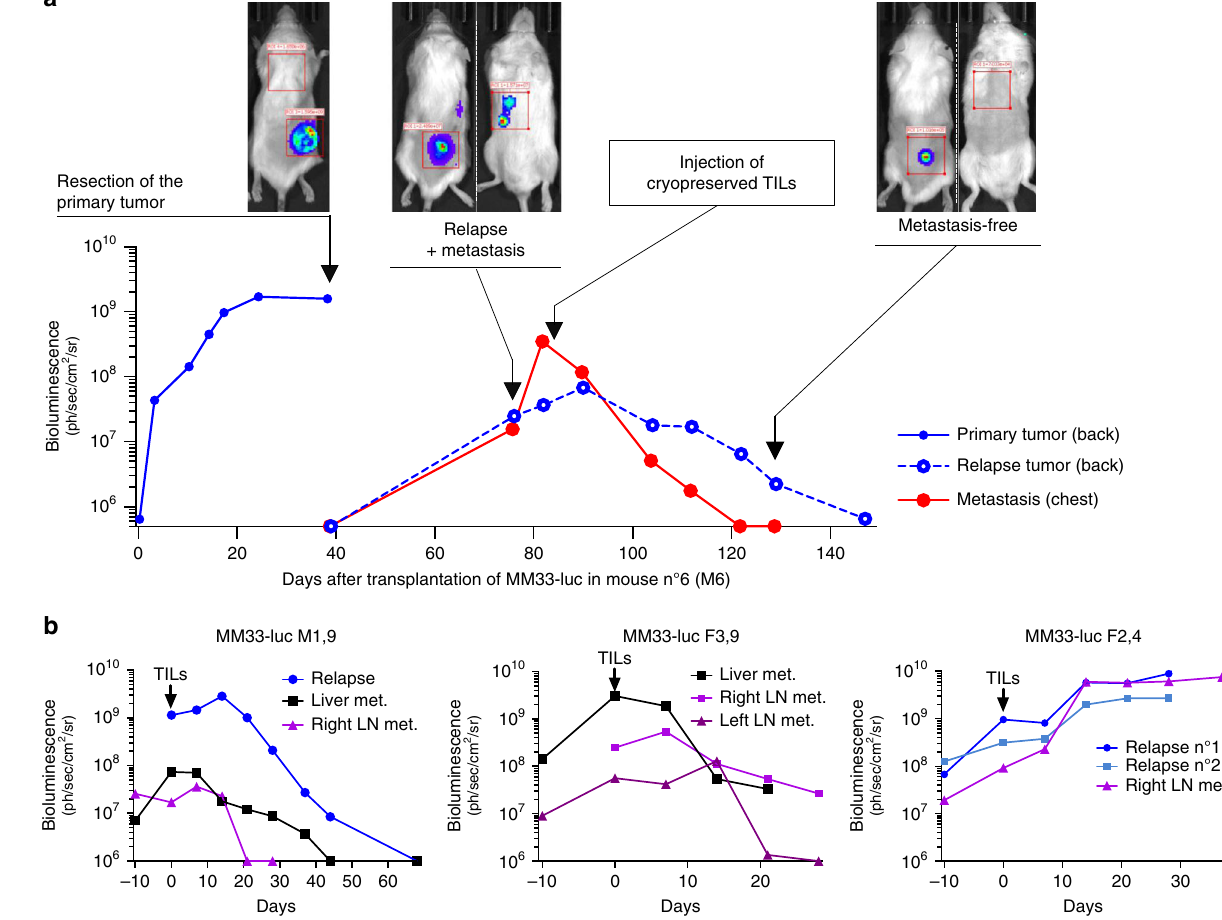
Fig. 5 Transgenic expression of human IL2 enables TIL-mediated tumor eradication of metastases in NOG mice. Transgenic hIL2 -NOG mice transplanted with luciferase labeled MM33 tumor cells were allowed to develop subcutaneous tumors until tumors reached > 500 mm 3 . The tumors were surgically removed and relapse was followed using the IVIS imager. When metastases had appeared TILs were injected and responses were measured by IVIS imaging. a A representative mouse showing the disease progression. b IVIS imaging of mice with additional sites of metastasis of melanoma. Graphs are labeled with gender of mouse (F or M) and corresponding plasma level of hIL-2